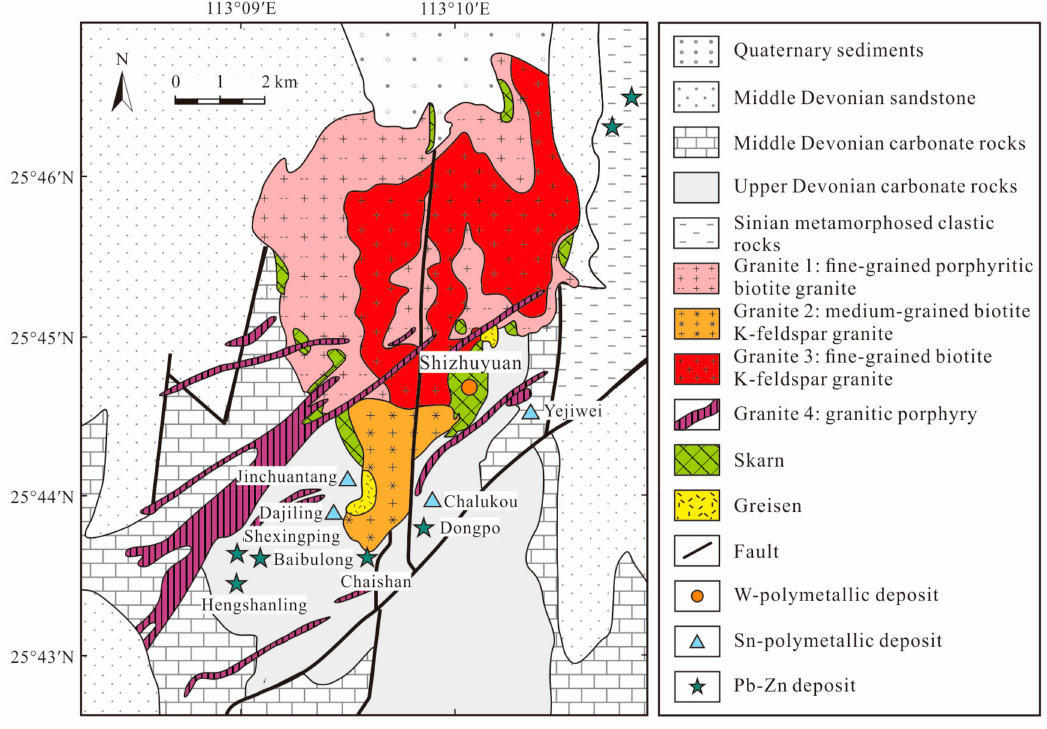
Figure 2. Schematic geological map of the Shizhuyuan W-polymetallic deposit (modified after Chen et al. [16] and Jiang et al.